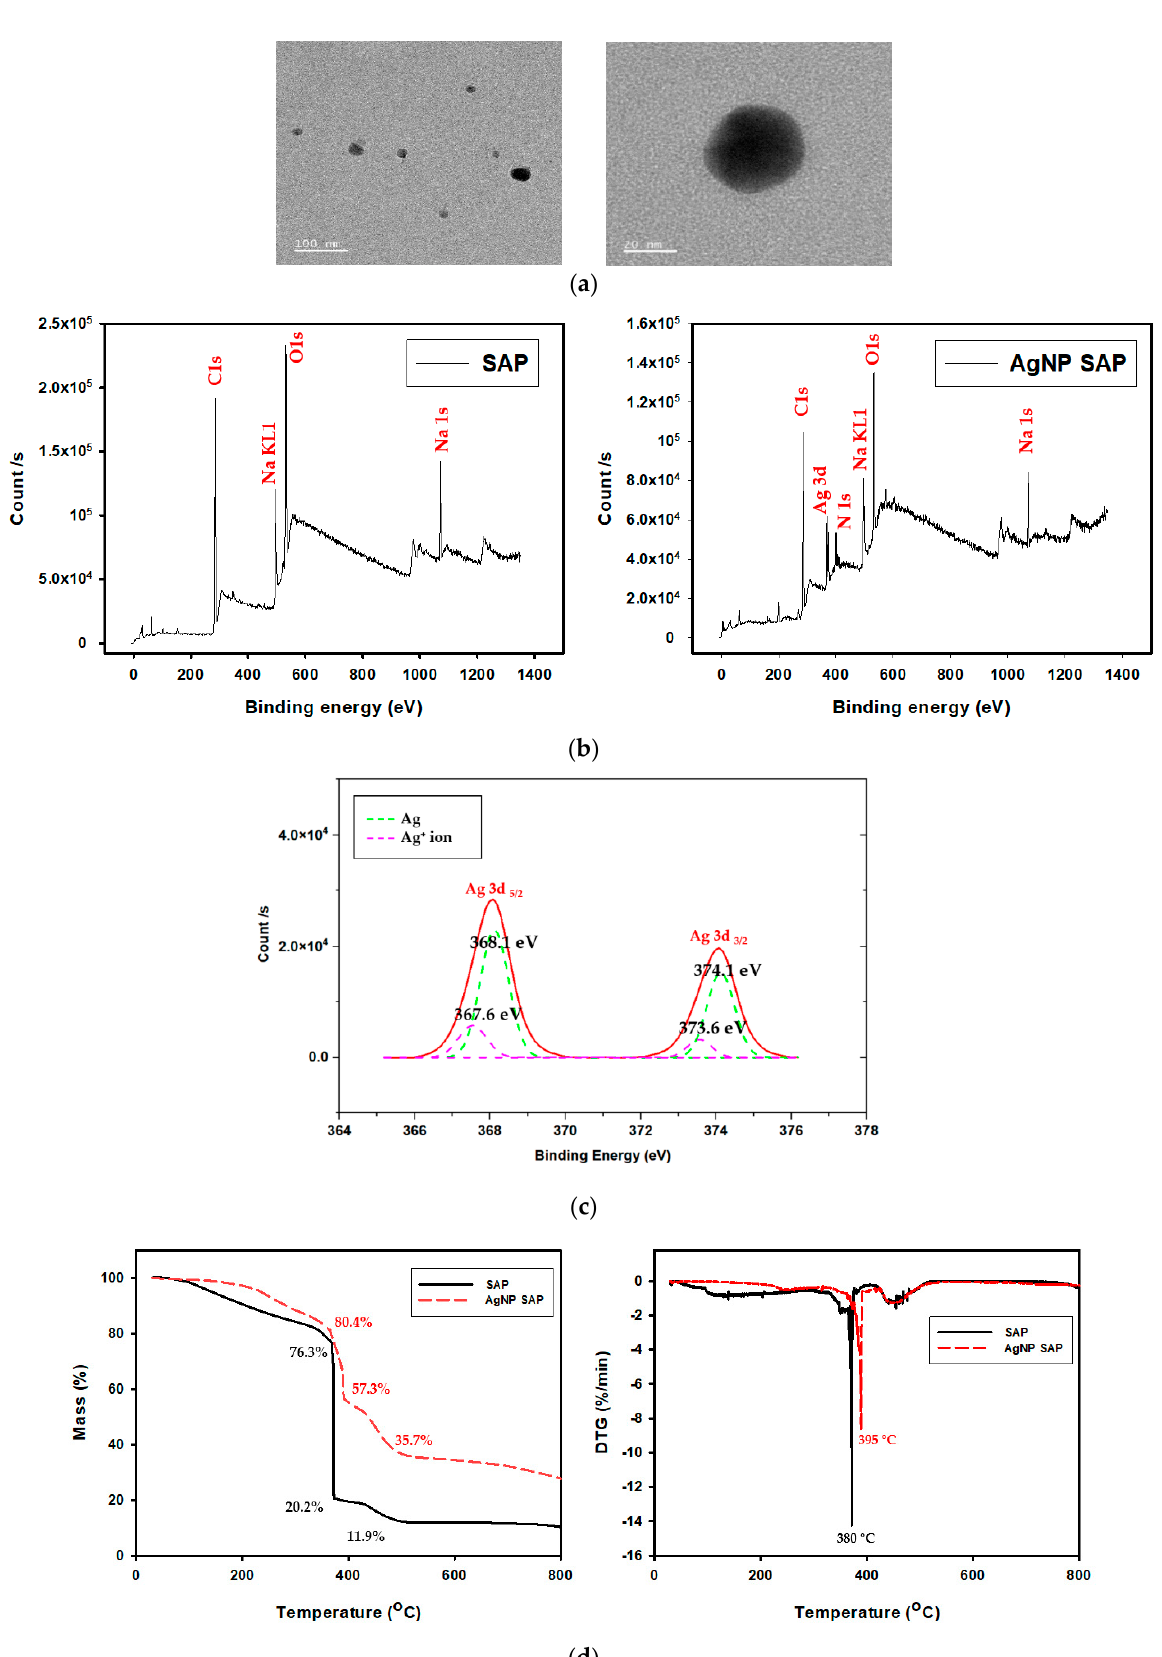
Figure 3. ( a ) TEM image of AgNPs produced in SAPs. ( b ) XPS spectra of bare SAP and AgNP-SAP. ( c ) High resolution XPS Ad3d spectra for the AgNP-SAP. ( d ) TGA and DTGA thermogram of SAP and AgNP-SAP.